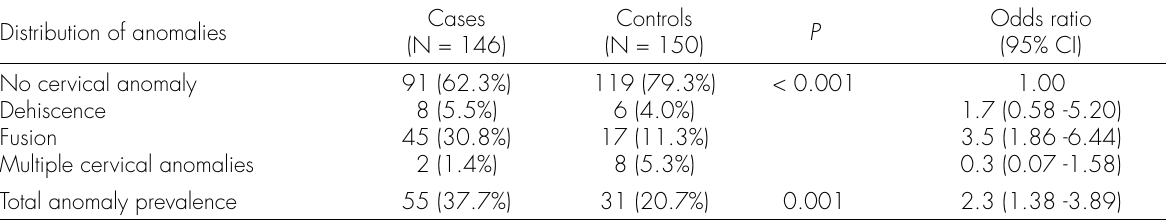
Table II. Comparison of cervical vertebrae anomalies in cleft and non-cleft patients.